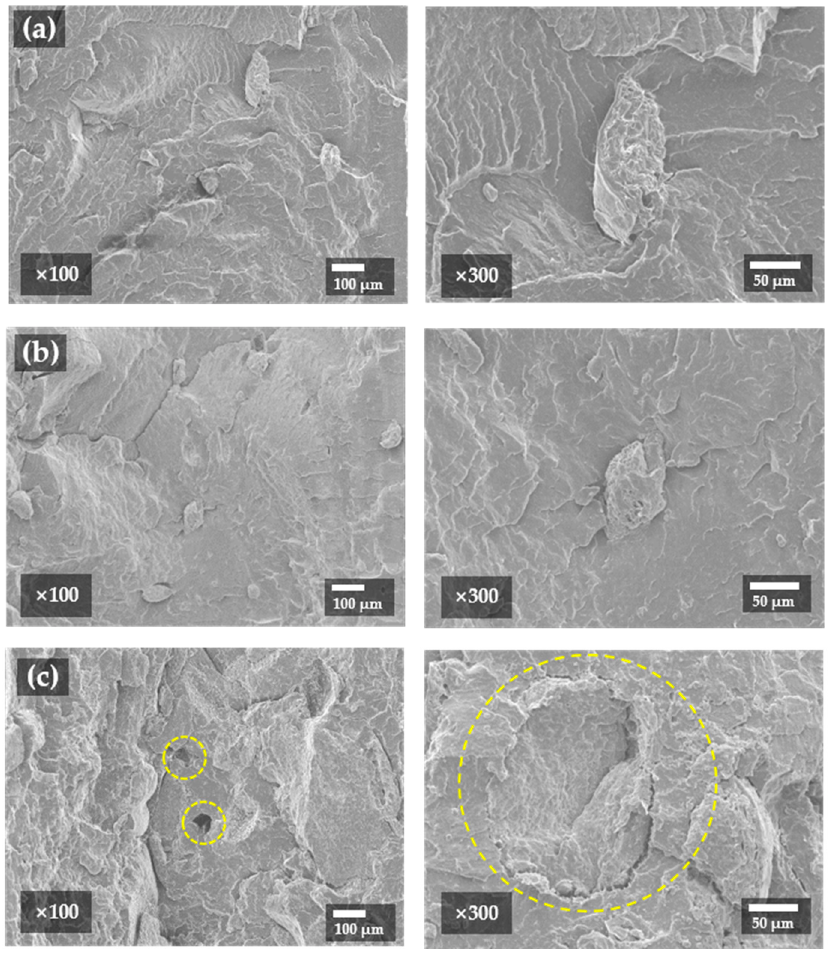
Figure 10. Scanning electron microscope (SEM) image of ( a ) Block-PP/SOC (BPS) with SOC 10%; ( b ) BPS with SOC 20%; and ( c ) BPS with SOC 30%.